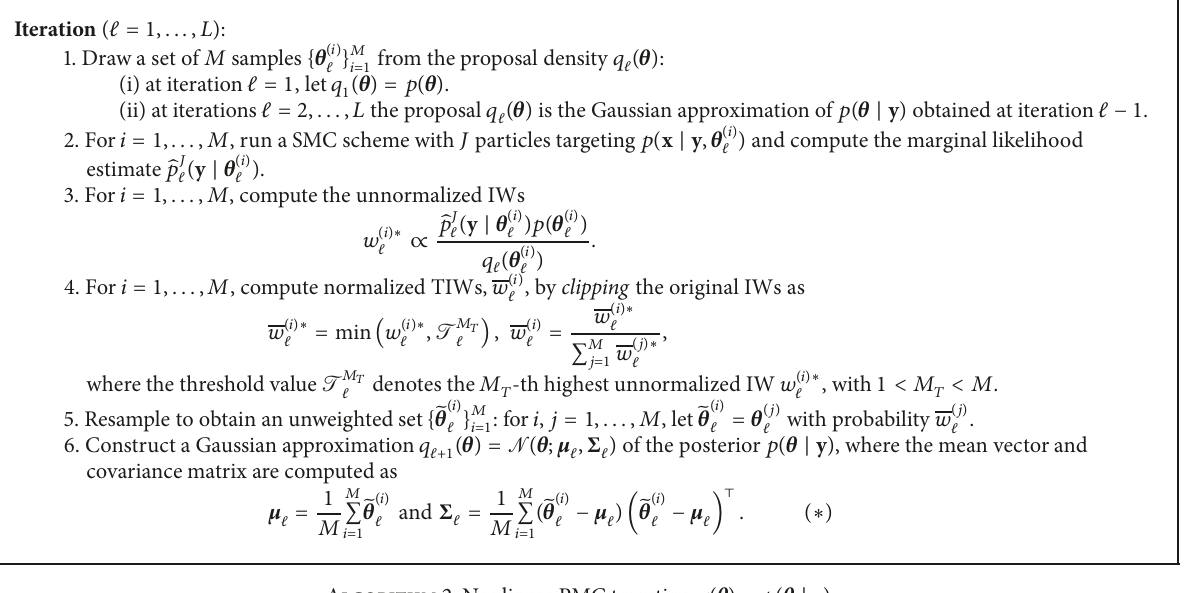
Algorithm 2: Nonlinear PMC targeting 𝜋( 𝜃 ) = 𝑝( 𝜃 | y )